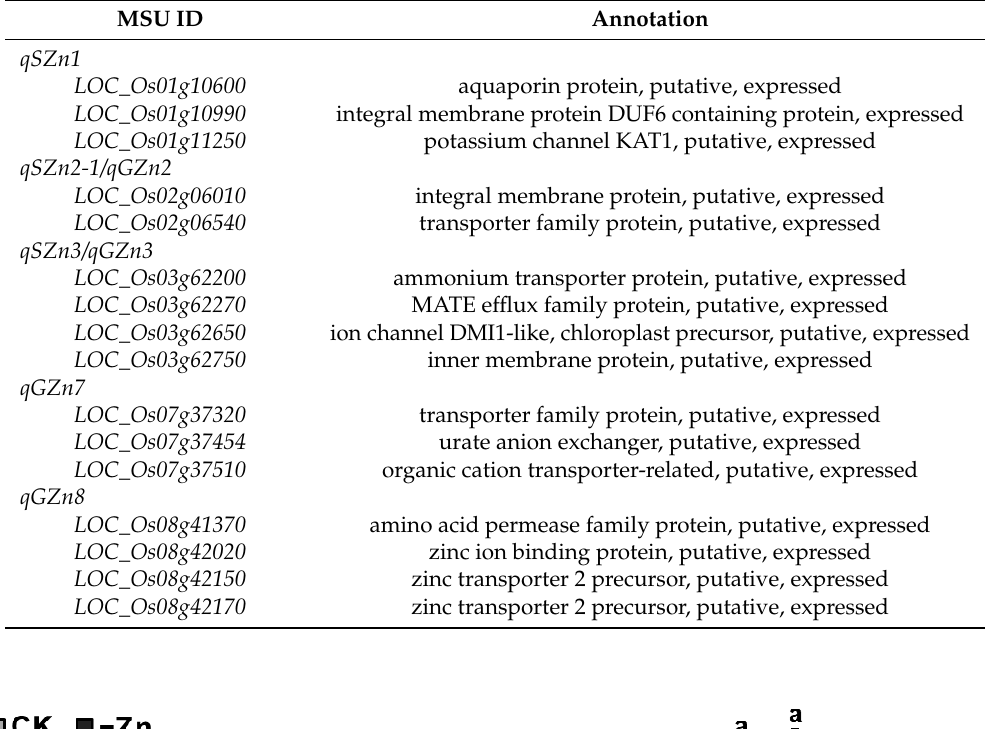
Table 2. Annotations of the selected candidate genes from promising QTLs detected for Zn 2+ accumulation.